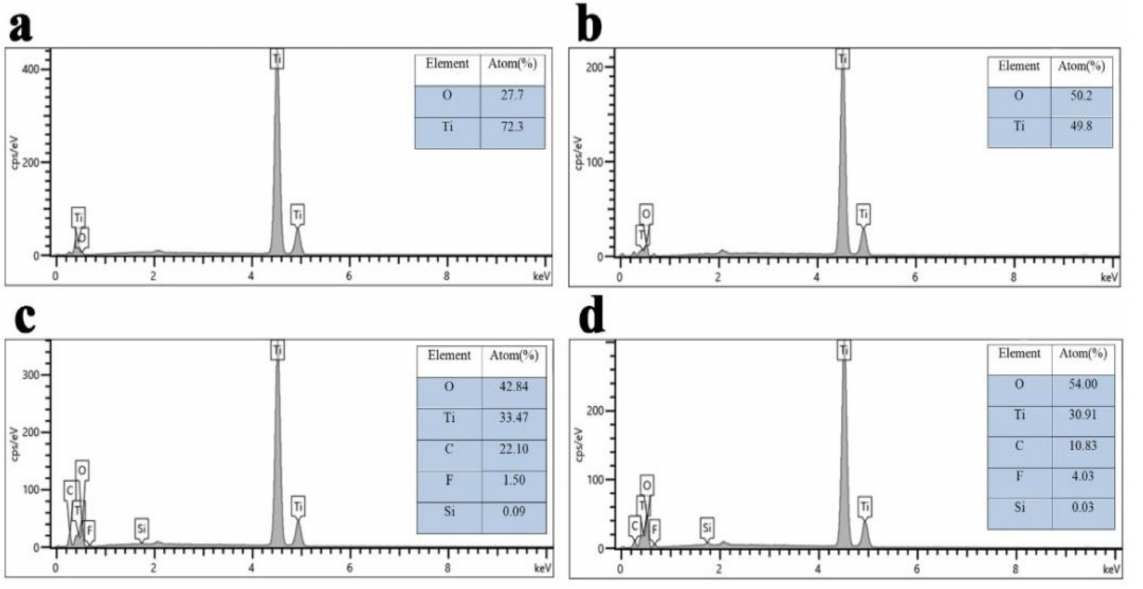
Figure 2. EDX for the pristine wire ( a ), the superhydrophilic wire ( b ), the superhydrophobic wire ( c ) and the UV-irradiated superhydrophilic wire ( d ).